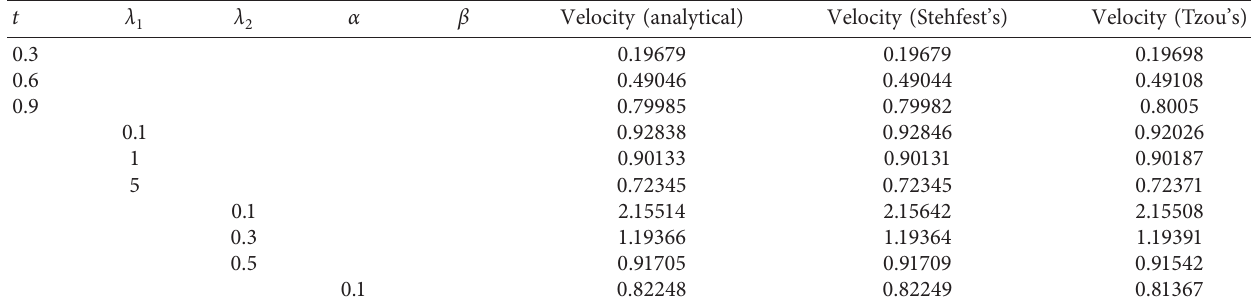
Figure 13: Tangential stresses of fractional Oldroyd-B fluid, classical Oldroyd-B fluid, fractional Maxwell fluid, and classical Maxwell fluid for both cos and sin. Table 2: Comparison of analytical and numerical solution for velocity profile of sin